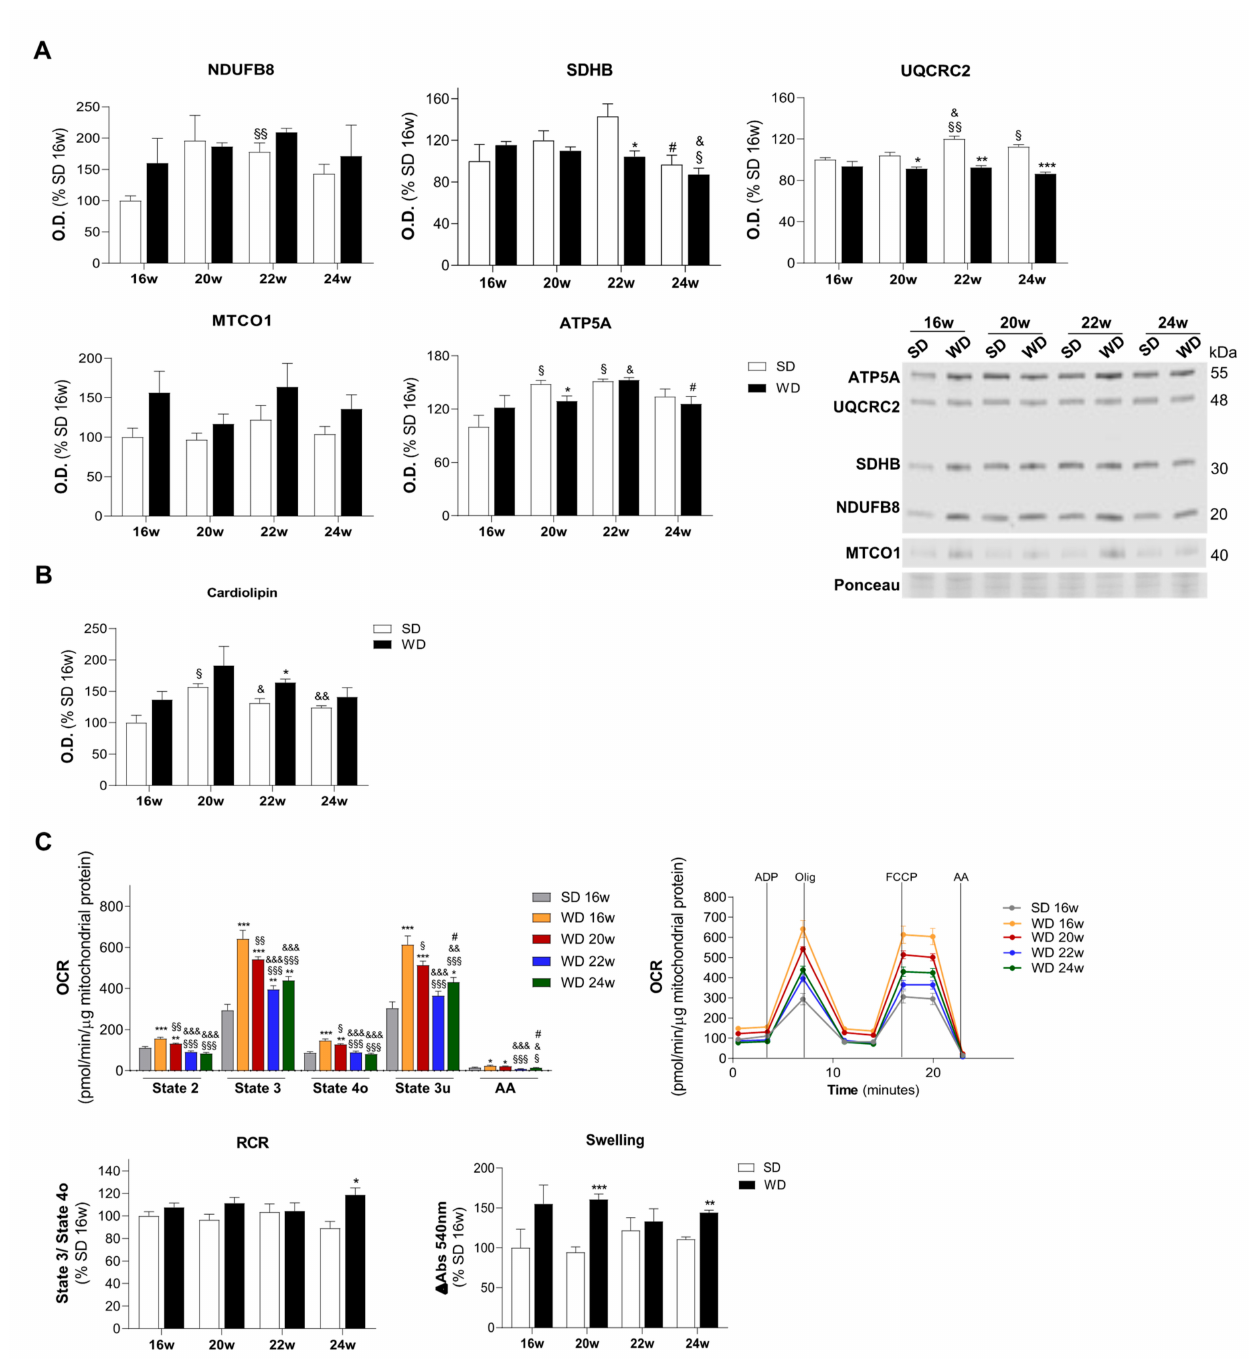
Figure 3. WD feeding induces a higher hepatic mitochondrial oxygen consumption rate (OCR) at 16 weeks, an effect that was decreased for longer timepoints and accompanied by mitochondrial permeability transition pore (MPTP) opening. ( A ) OXPHOS subunits levels (NDUFB8, complex I; SDHB, complex II; UQCRC2, complex III; MTCO1, complex IV; ATP5A, ATP synthase) expressed as optical density (arbitrary units), with Ponceau being used as a loading control. Representative image of OXPHOS subunits Western blot. ( B ) Cardiolipin levels present in liver mitochondria. ( C ) OCR of CII-linked hepatic mitochondrial respiration supported by succinate (left panel); and a representative profile of OCR (right panel); Respiratory control ratio (RCR) (state 3/state 4o) and opening MPTP—swelling (lower panel). Number of replicates = 3. All data are expressed as the mean ± SEM. (*) vs. SD, (§) vs. 16 w, (&) vs. 20 w, (#) vs. 22 w ( p < 0.05); (**) vs. SD, (§§) vs. 16 w, (&&) vs. 20 w ( p < 0.01); (***) vs. SD, (§§§) vs. 16 w, (&&&) vs. 20 w ( p < 0.001); p values were determined using two-way ANOVA. AA, antimycin A; FCCP, carbonyl cyanide-p-trifluoromethoxyphenylhydrazone; Olig, oligomycin; SD, standard chow diet; WD, Western